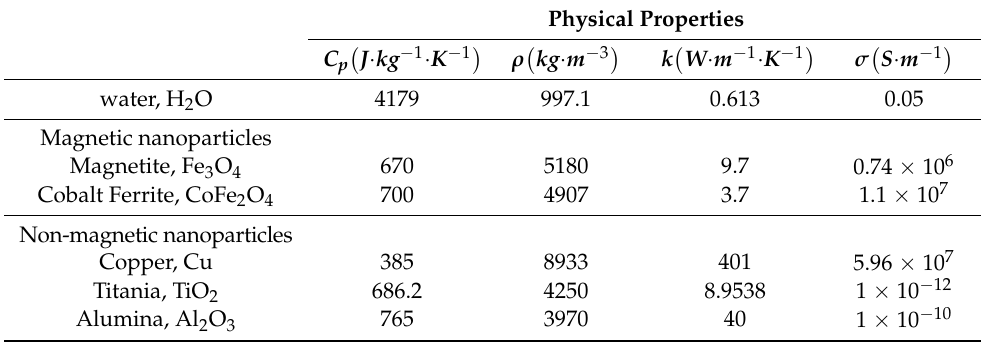
Table 2. Thermophysical properties of nanoparticle and base